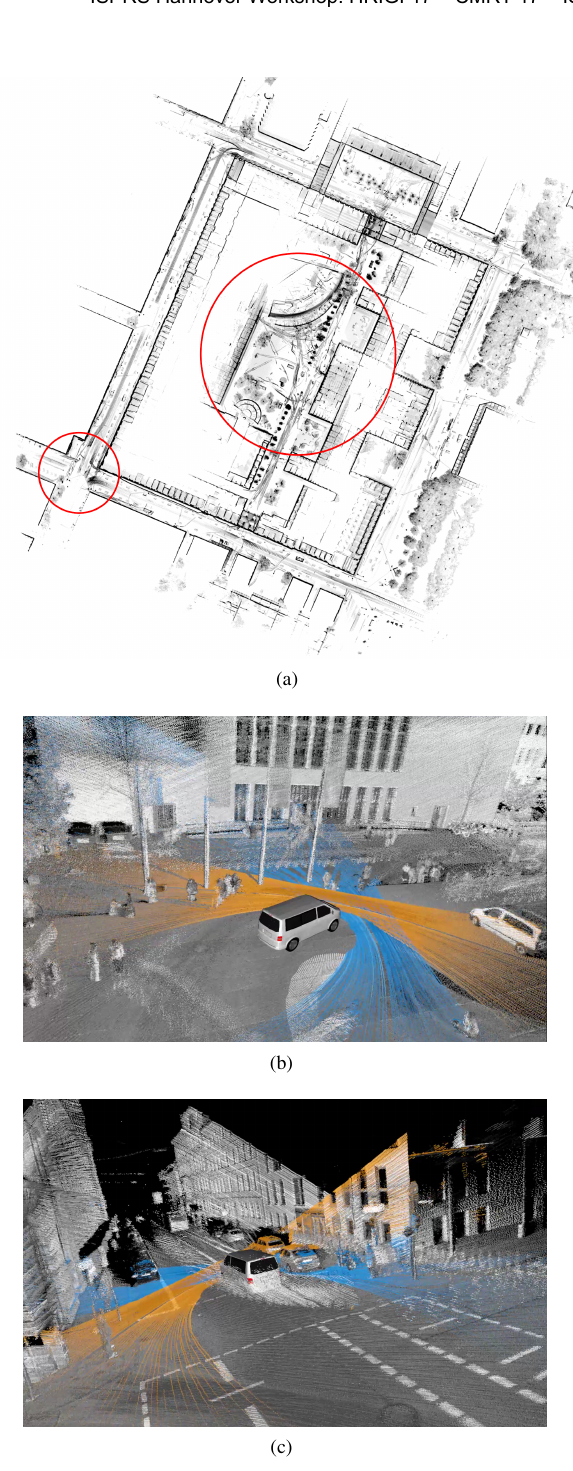
Figure 4. The TUM City Campus dataset. (a) Overview. (b) Inner Yard. (c)